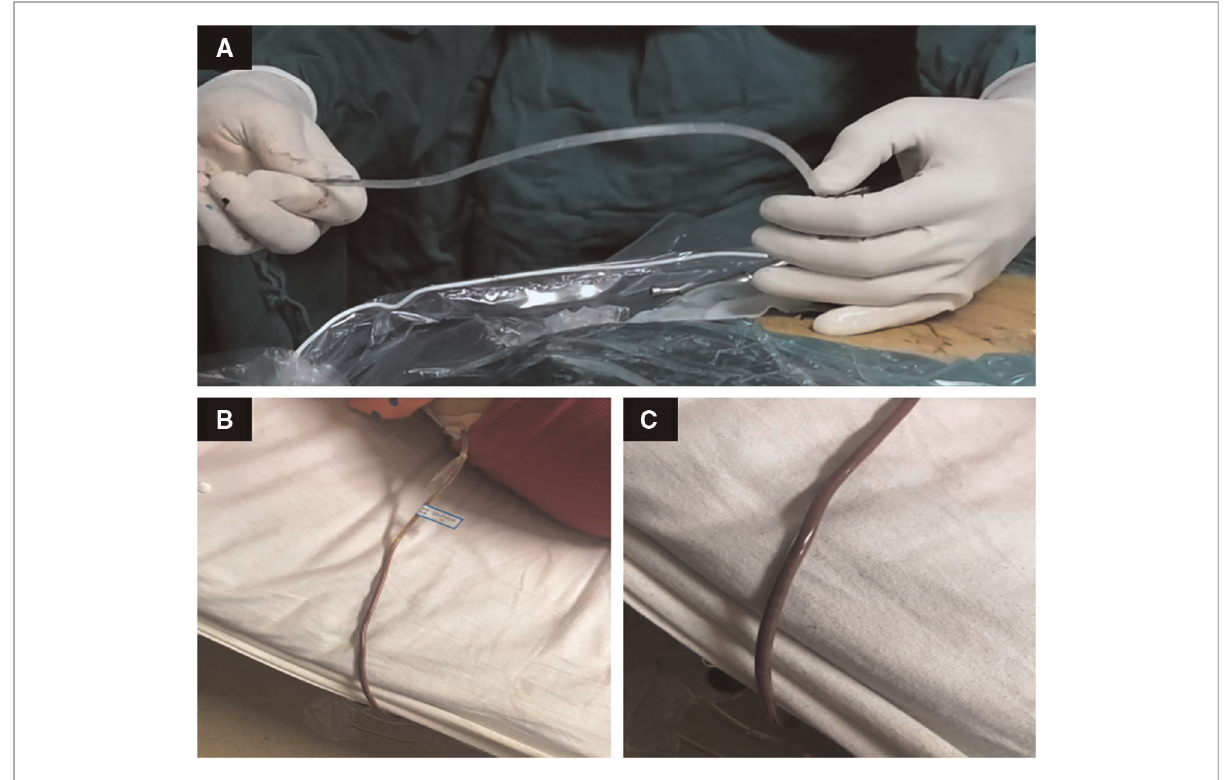
FIGURE 5 Postoperative drainage of pus.